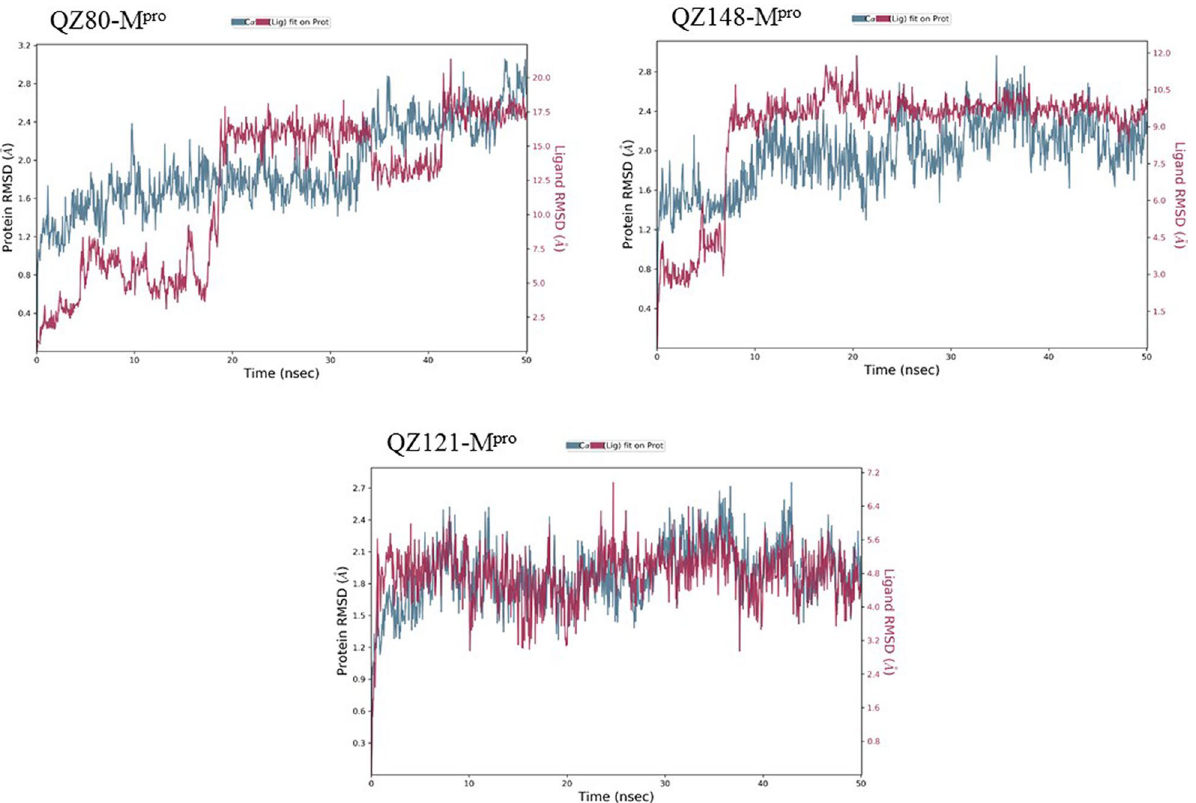
Figure 9. Root mean square deviation (RMSD) plots for docked complexes of QZ-M pro